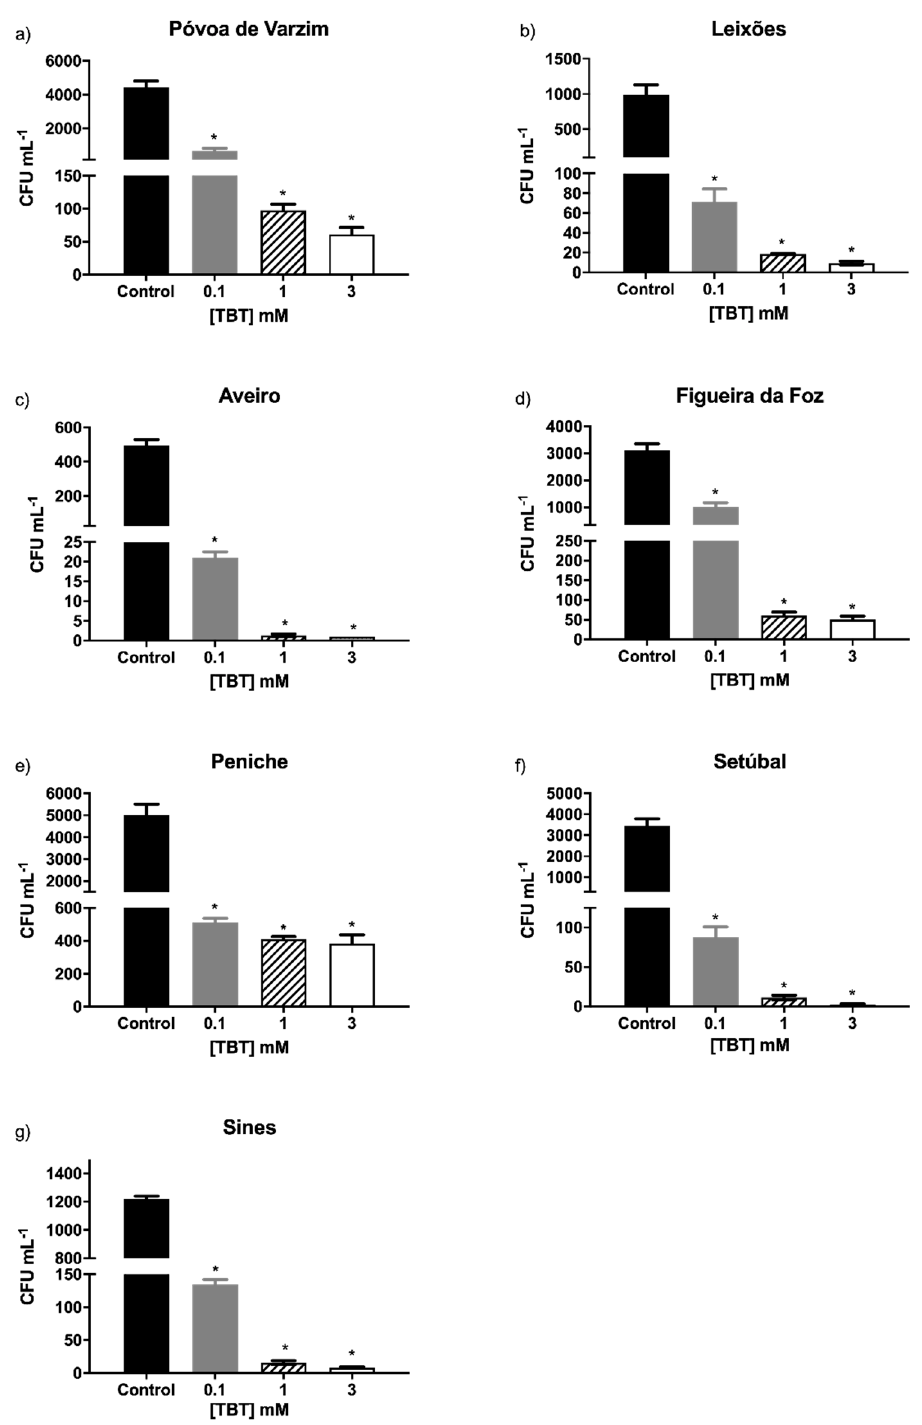
Figure 1. Relationship between concentration of tributyltin (0, 0.1, 1, and 3 mM) and CFUs for all de Varzim; ( b ) Leix õ es; ( c ) Aveiro; ( d ) Figueira da Foz; ( e ) Peniche; ( f ) Set ú bal; ( g ) Sines. Results presented as mean + SEM. sampling sites ( a ) Póvoa de Varzim; ( b ) Leixões; ( c ) Aveiro; ( d ) Figueira da Foz; ( e ) Peniche; ( f ) Setúbal; ( g ) Sines. Results presented as mean + SEM. Asterisk indicates significant differences be- Asterisk indicates significant differences between treatments and control, p < tween treatments and control, p < 0.05.